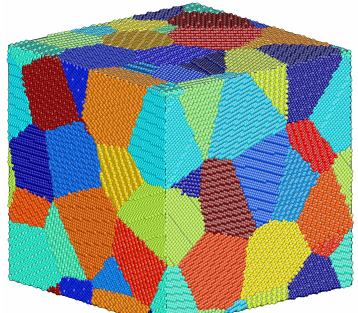
Figure 1. Initial model of nanocrystalline BCC-Fe, the atom was colored according its grain ID